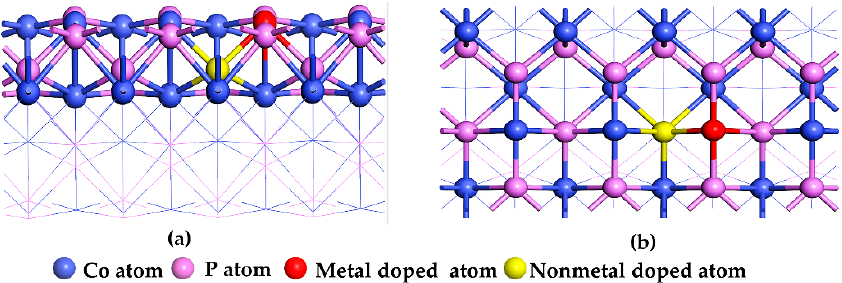
Figure 1. Front view ( a ) and top view ( b ) of metal- and non-metal-doped CoP catalyst.